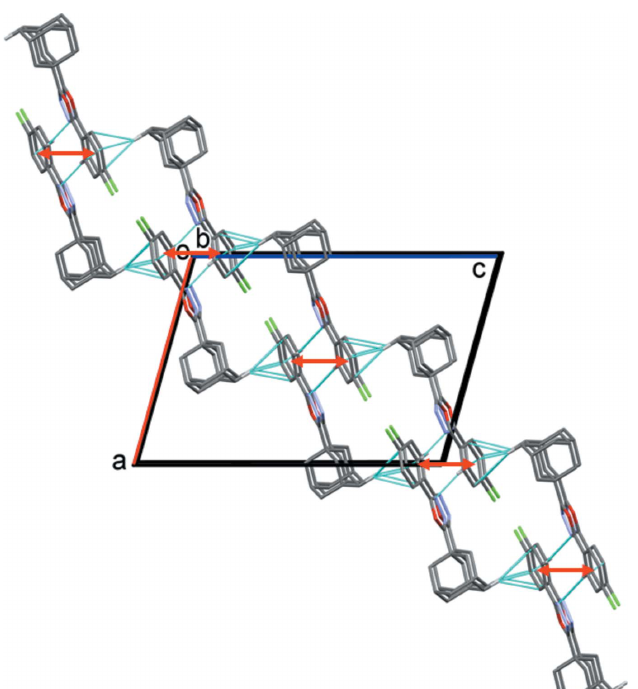
Figure 5 A view along the b axis of the crystal packing of compound (II), showing the C—H (cid:2)(cid:2)(cid:2) N hydrogen bonds and the C—H (cid:2)(cid:2)(cid:2) (cid:2) interactions (see Table 2) as dashed lines. The offset (cid:2) – (cid:2) interactions are indicated by double-headed red arrows. For clarity, only hydrogen atoms H3 and H12 A have been included.